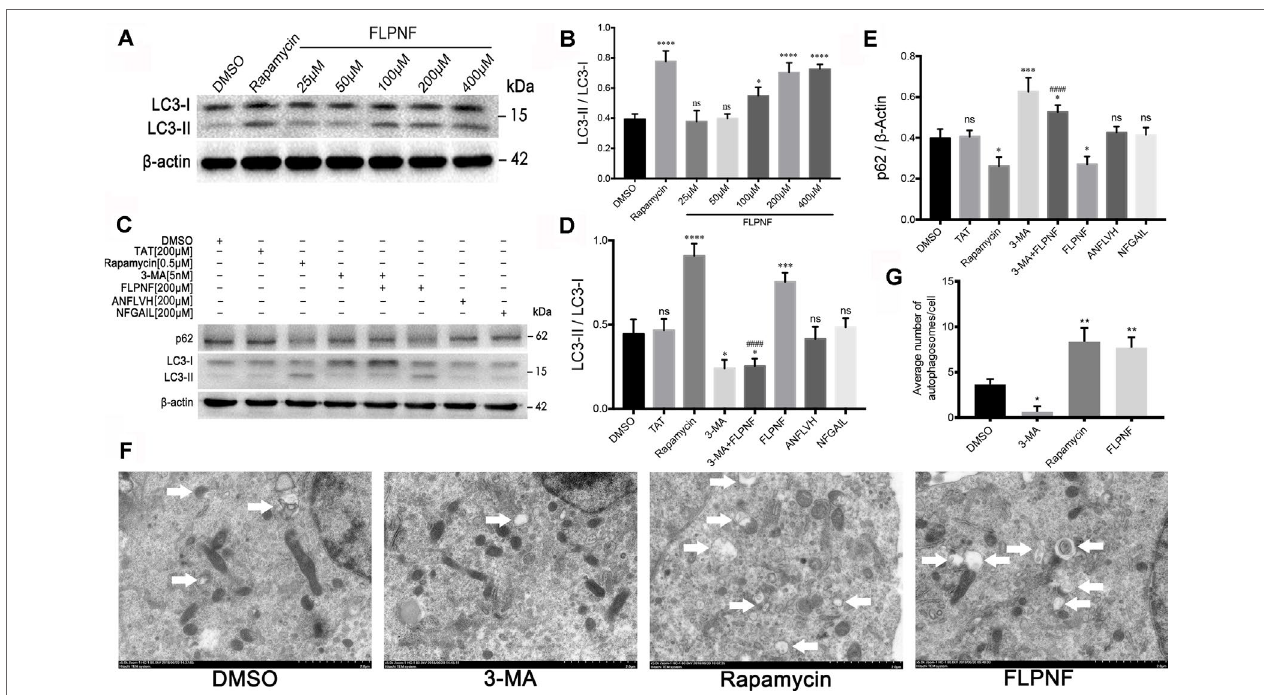
FIGURE 2 | Peptide FLPNF significantly increases the autophagosomal number in hIAPP-INS-1 cells. (A) Western blot analysis revealed changes in LC3-I and LC3-II at different concentration of the peptide FLPNF. β -actin was used as loading control. (B) The graph represents the quantification of LC3-II protein levels (n = 4). * p < 0.05, **** p < 0.0001, and ns vs. DMSO group. (C) Protein levels of LC3 and p62 were assessed by Western blot in hIAPP-INS-1 cells after exposure to 200 μM peptide FLPNF for 24 h. Rapamycin (0.5 μM for 6 h), 3-MA (5 nM for 6 h), peptide ANFLVH (200 μM for 24 h), and peptide NFGAIL (200 μM for 24 h) were used as a control. (D) and (E) The graph represents the quantification of LC3-II and p62 protein levels, respectively (n = 4). * p < 0.05, *** p < 0.001, **** p < 0.0001, and ns vs. DMSO group. #### p < 0.0001 vs. peptide FLPNF group. (F) Autophagy was evaluated using TEM, autophagosome are represented by double membrane vesicles and denoted with white arrow. Magnification 50,000×. (G) Quantification of the average number of autophagosomes per cell was determined by counting manually in 30 randomly selected cells for each group (n = 3). * p < 0.05 and ** p < 0.01 vs. DMSO